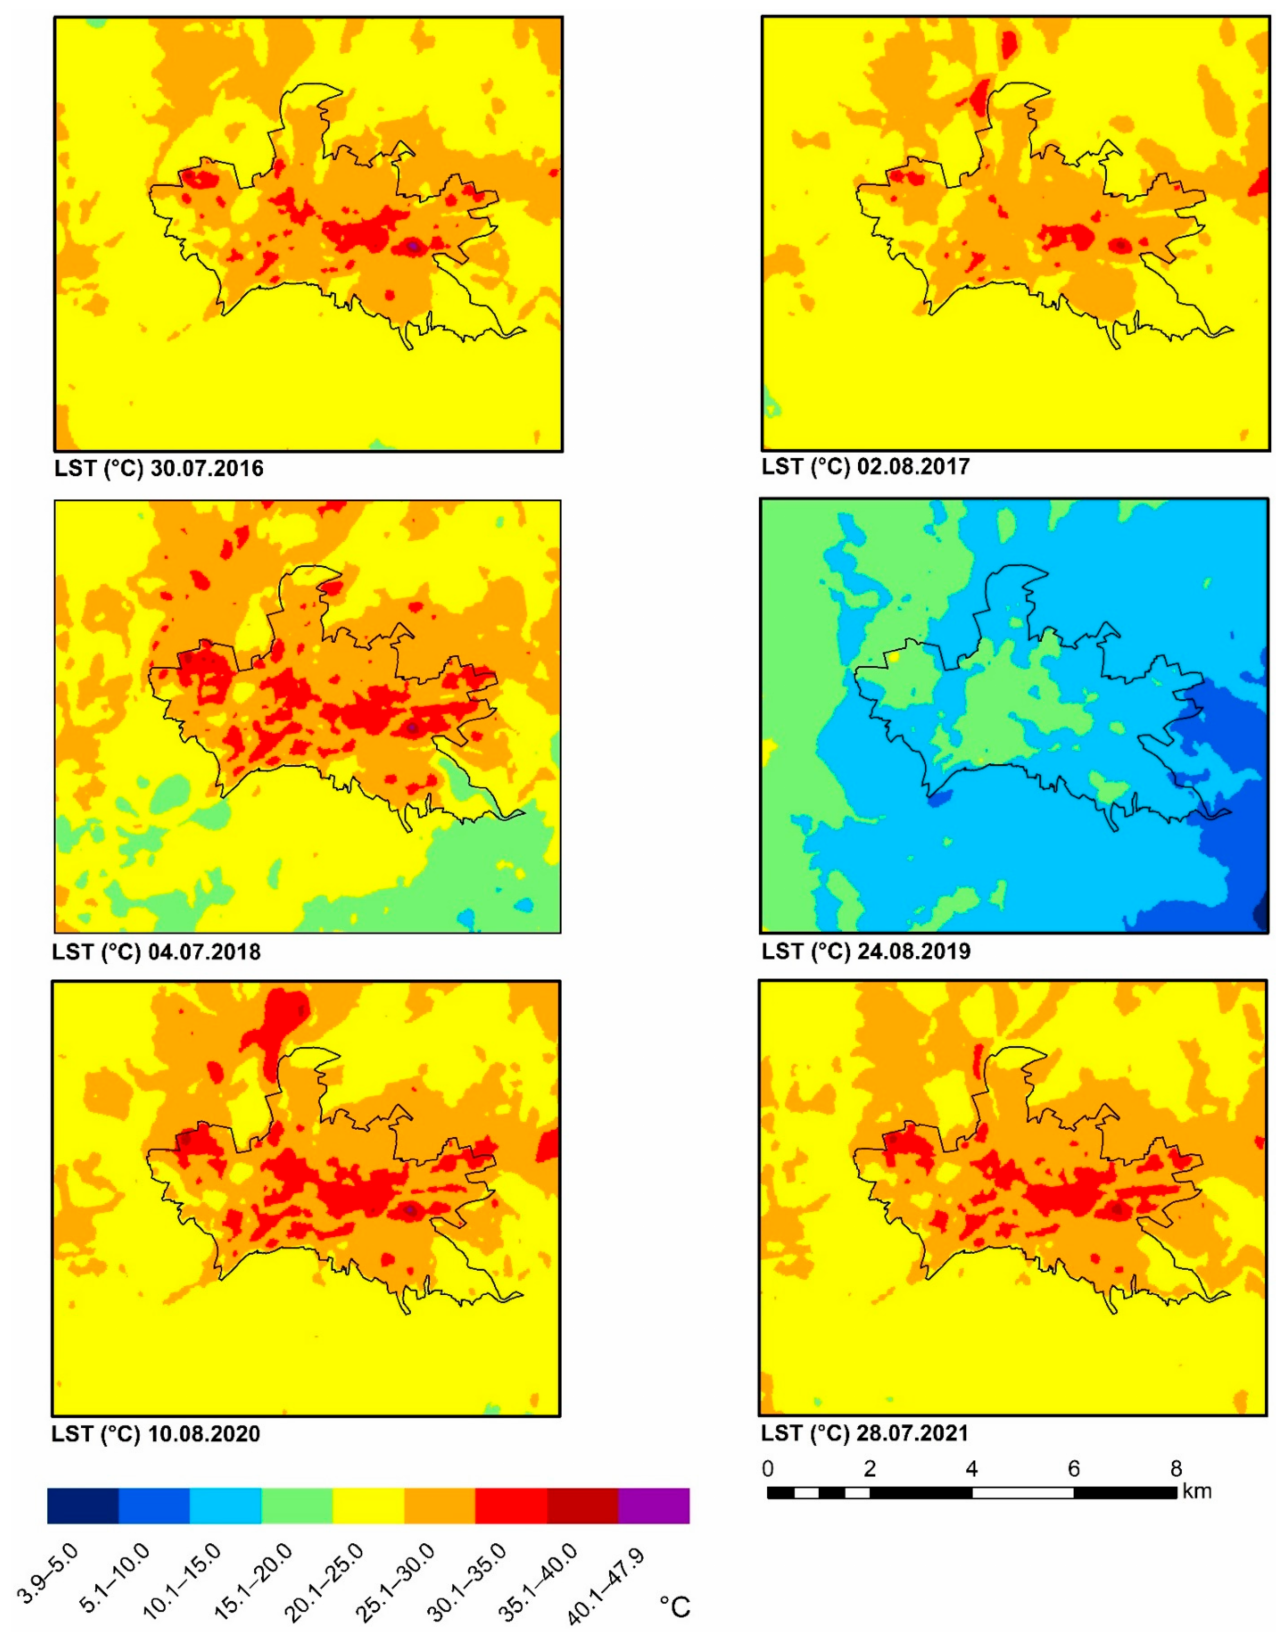
Figure 6. Calculated LST values for evaluated days between the years